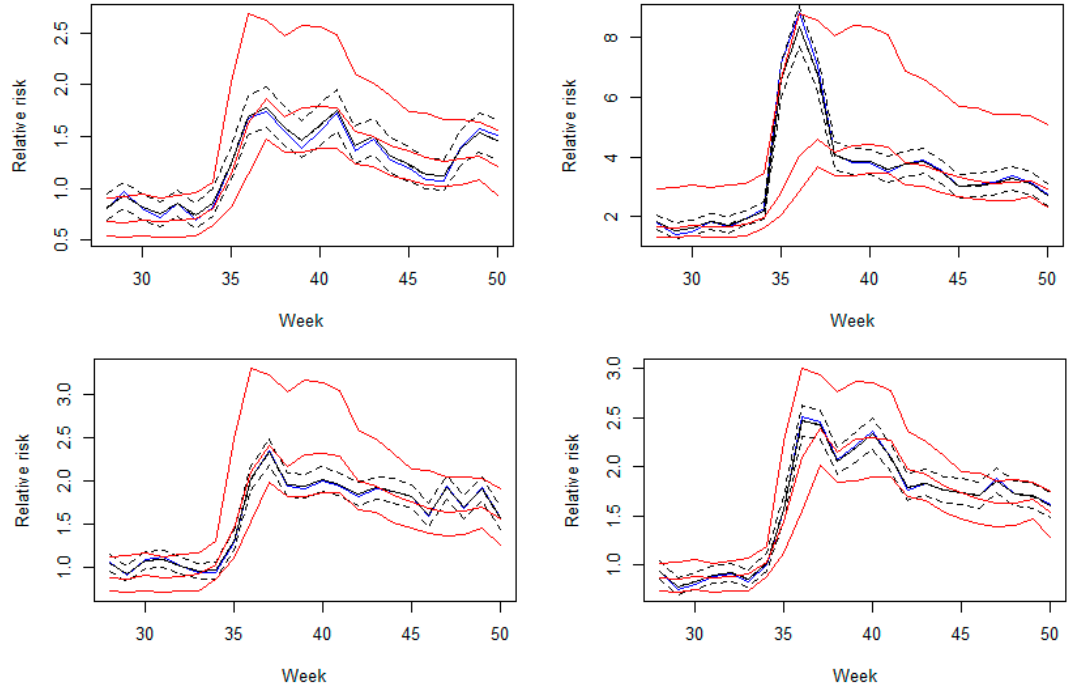
Figure 7. Plots of crude relative risks (standardized incidence rate; blue), posterior mean relative risks (solid black) with corresponding 95% credible intervals (dash black), and estimated 5th, 50th and 95th quantiles from log-Laplace regression (solid red) for Beaufort (upper left), Greenwood (upper right), Charleston (lower left), and Richland (lower right) counties.